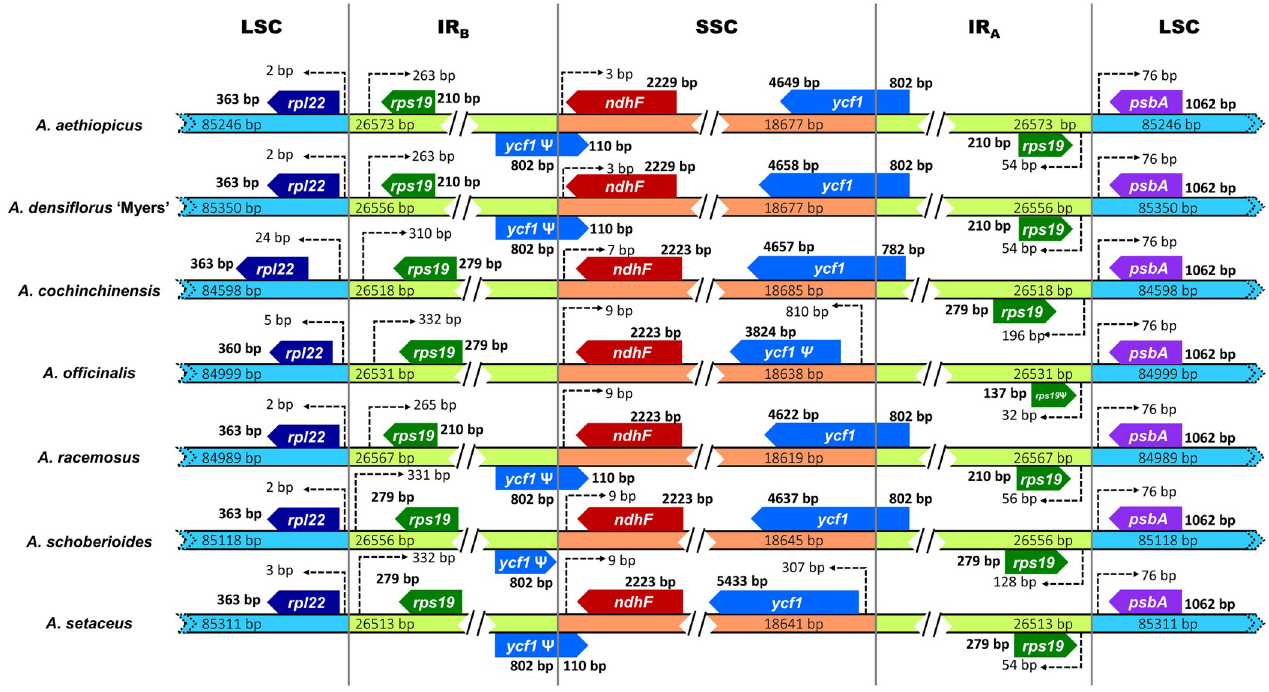
Fig 8. Large single copy (LSC), small single copy (SSC), and inverted repeat (IR) boundary comparison for the seven Asparagus cpDNA genomes. Numbers in bold indicate the size of the gene (or gene section) within the specified regions. The numbers next to the dashed arrows indicate distances from the specified junctions. Numbers within the coloured bands indicate the lengths of the respective regions. The direction of gene transcription is presented by the obtuse angles of the pentagons. C , pseudogene. Not to scale.